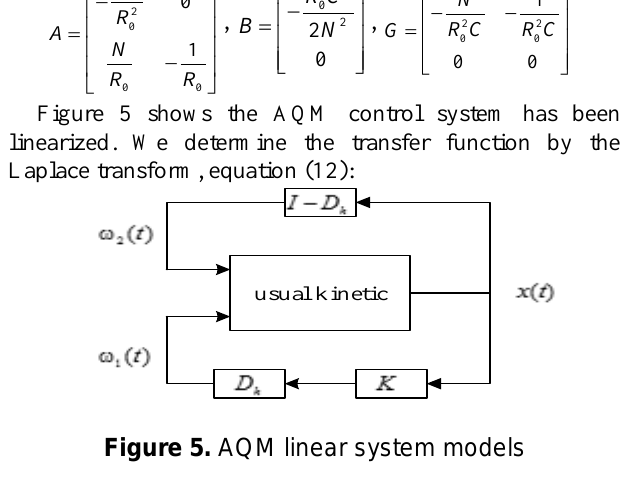
Figure 5. AQM linear system models